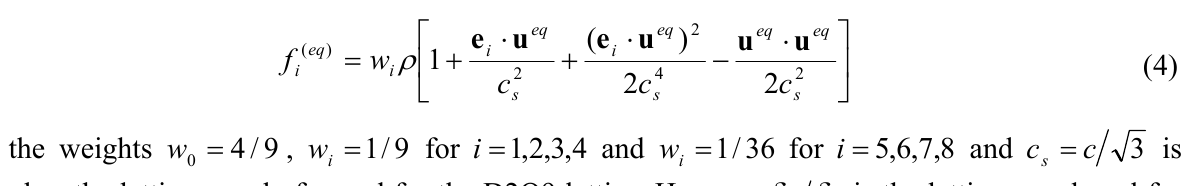
Figure 1. Lattice geometry and velocity vectors of ( a ) the D2Q9 model and ( b ) the D2Q5model. In this